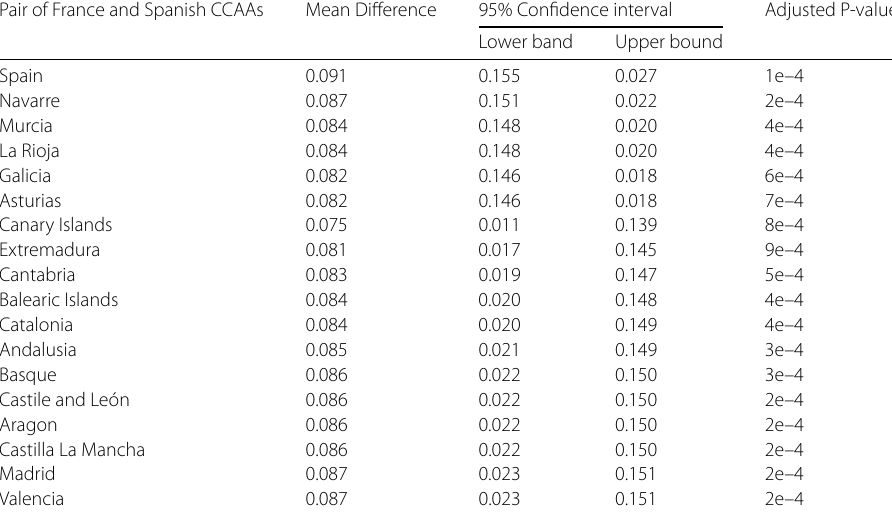
Table 9 HSD Tukey test results filtered by for the pair of CCAAs-countires which include France Pair of France and Spanish CCAAs Mean Difference Spain